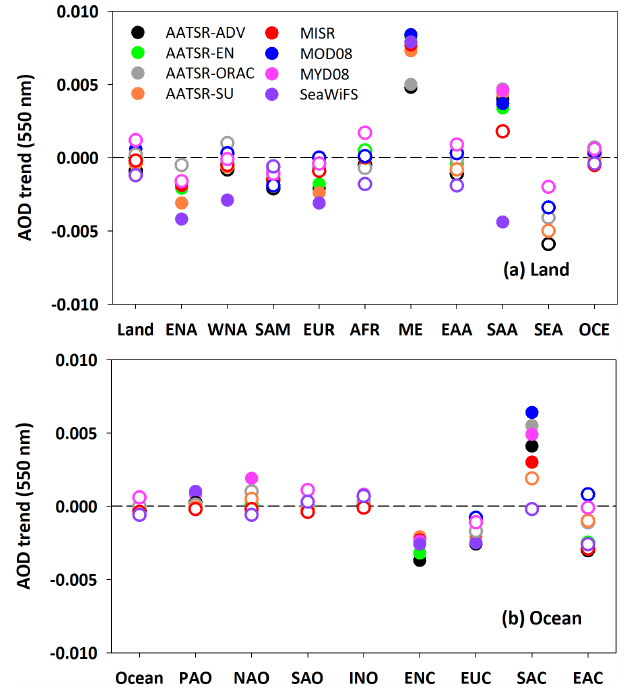
Figure 15. Regional linear trends based on de-seasonalized monthly AOD S anomalies over land and ocean from 2003 to 2010, where the hollow and solid circles represent statistically nonsignificant and significant trends at the 95% confidence level ( p < 0 . 05), respec-